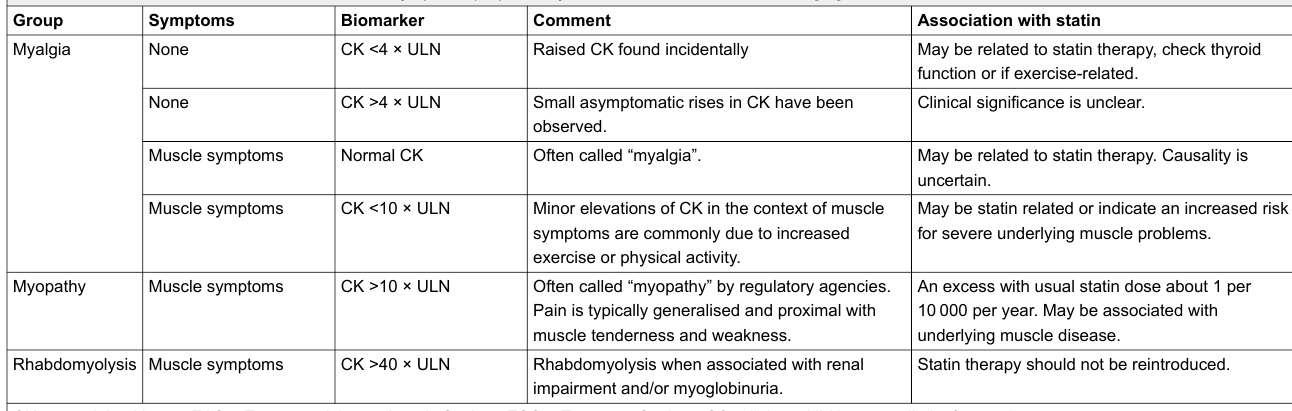
Table 1: Classification of statin-associated muscle symptoms proposed by the EAS/ESC Consensus Panel [11].